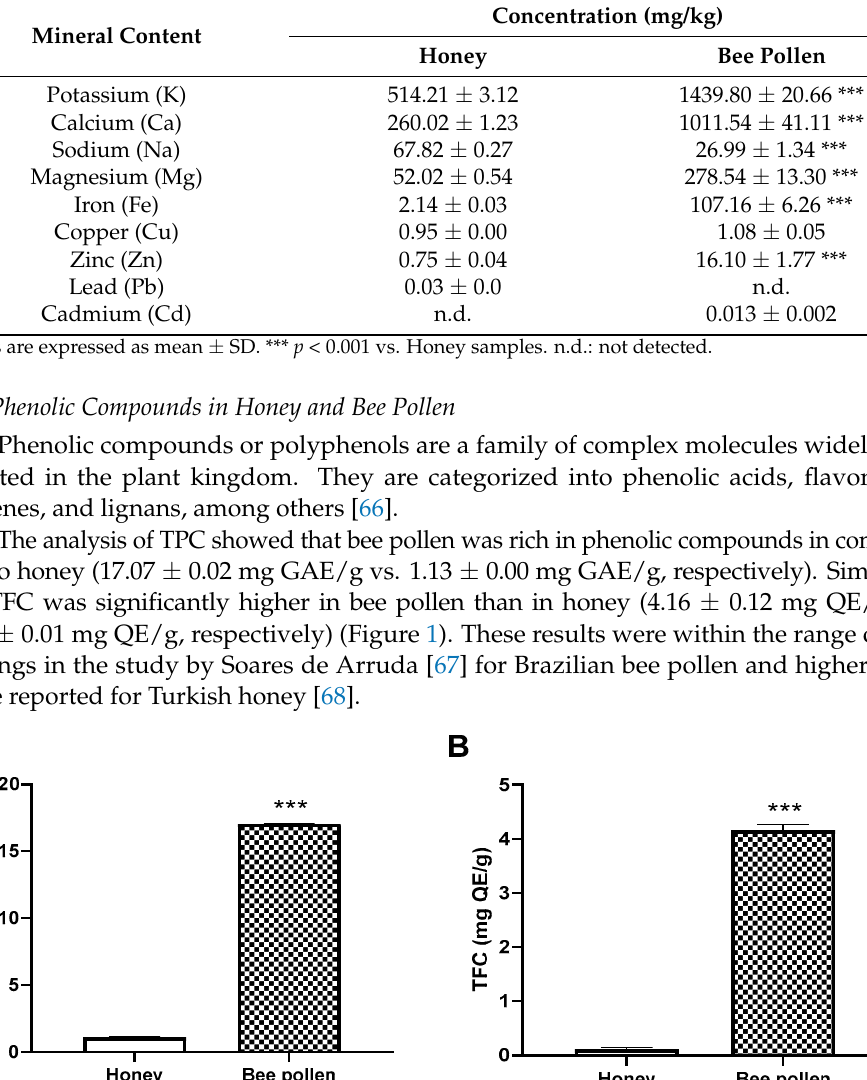
Table 6. Minerals content in honey and bee pollen.